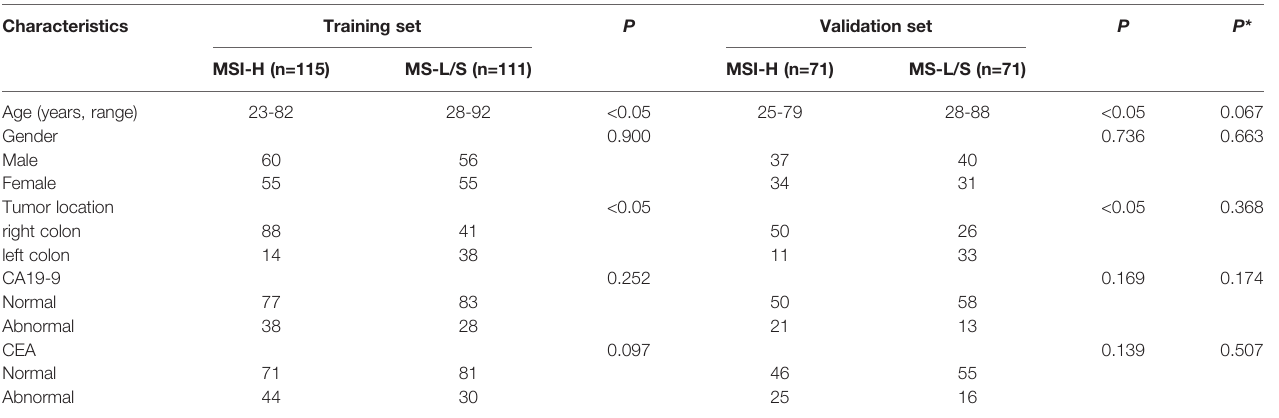
TABLE 1 | Characteristics of CRC patients in the MSI-H group and MS-L/S group.